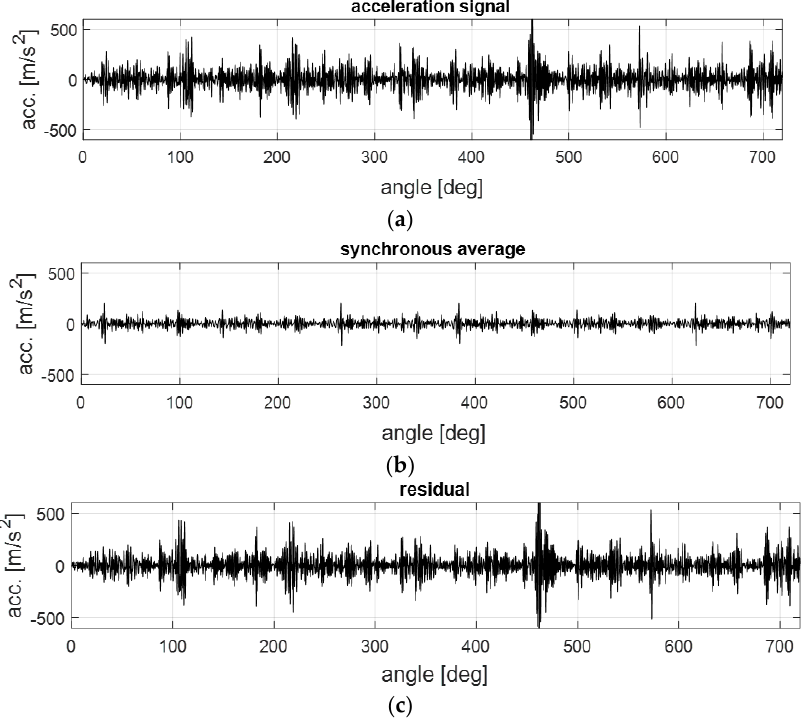
Figure 4. ( a ) Raw signal, ( b ) synchronous average, and ( c ) residual signal for the signal acquired with sensor 1 in the case of the faulty pump (1500 r/min, 150 bar).